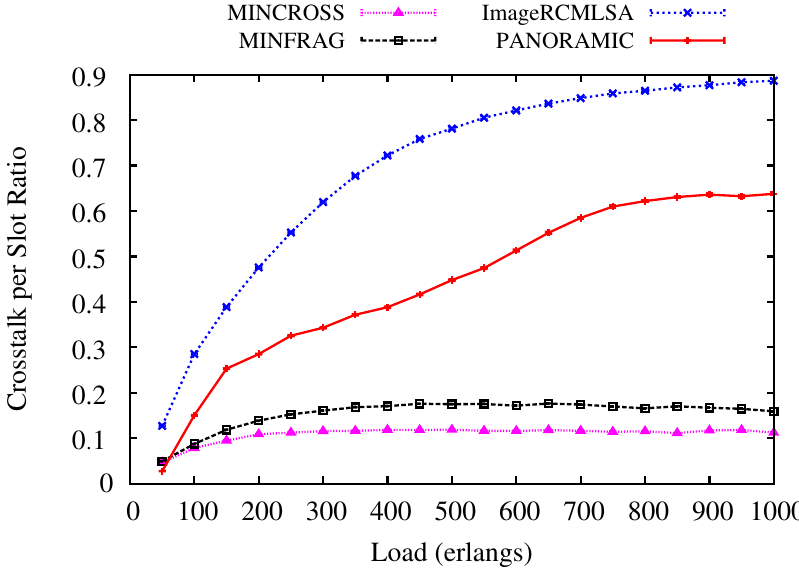
Figure 12. Crosstalk per Slot for USA